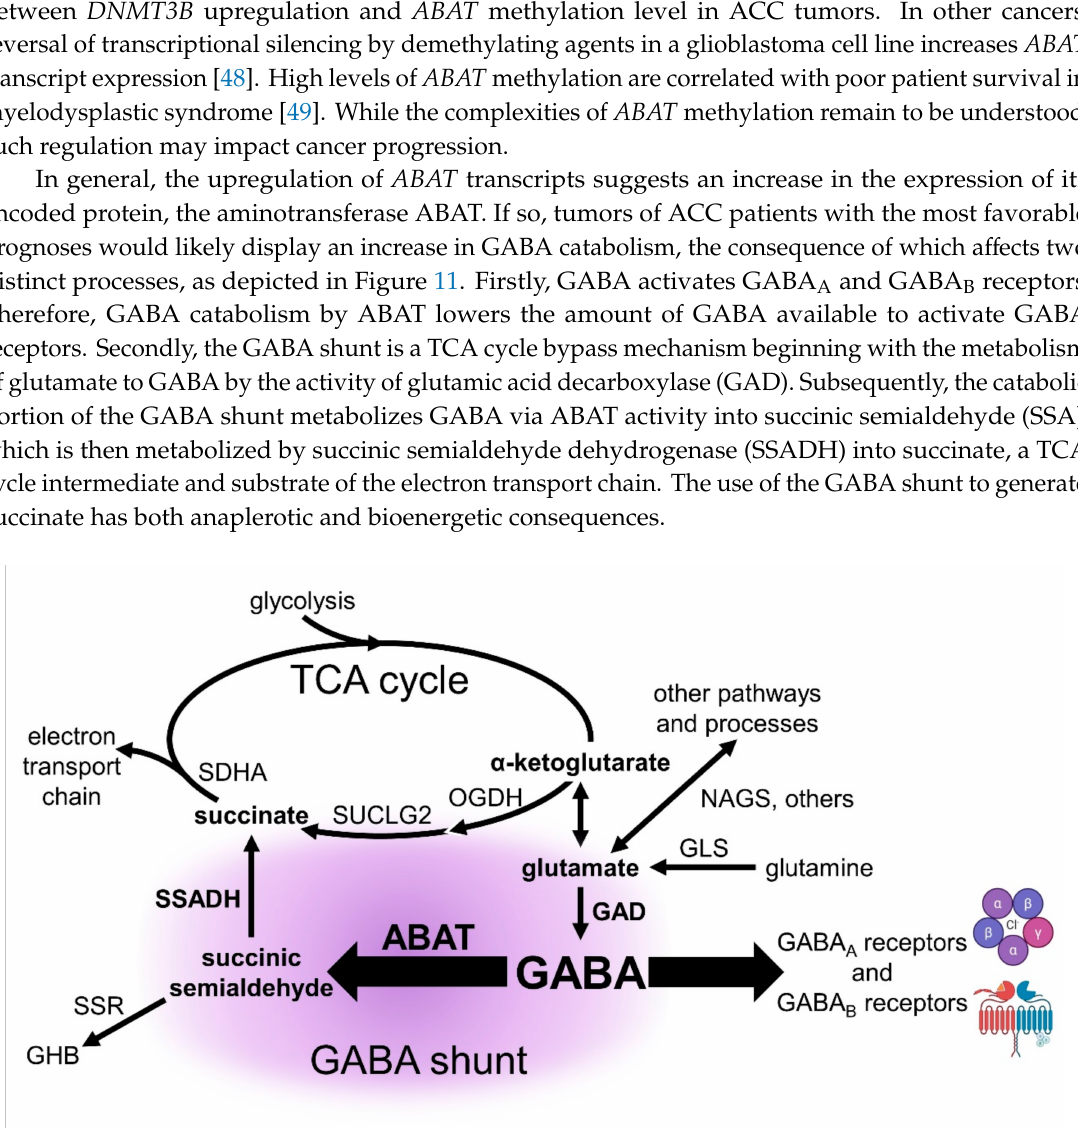
Figure 11. Schematic of GABA shunt, indicating consequences of upregulated ABAT transcripts. An increase in ABAT transcript, protein, and activity may result in a decrease in GABA levels, and ultimately a decrease in activation of GABA receptors. ABAT = γ -aminobutyrate aminotransferase; GAD = glutamic acid decarboxylase; GHB = gamma-hydroxybutyrate; GLS = glutaminase; NAGS = N -acetylglutamate synthase; OGDH = oxoglutarate dehydrogenase; SDHA = succinate dehydrogenase complex flavoprotein subunit A; SSADH = succinic semialdehyde dehydrogenase; SSR = succinic semialdehyde reductase; SUCLG2 = succinate-CoA ligase [GDP-forming] subunit beta,